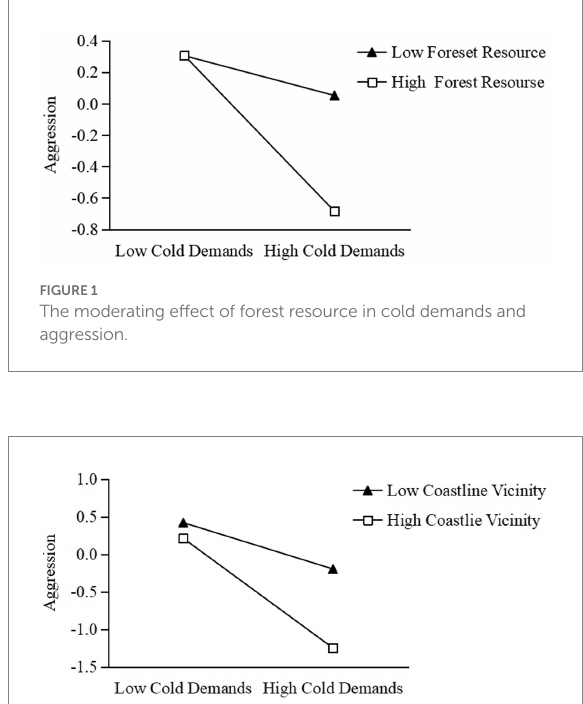
FIGURE 2 The moderating effect of coastline vicinity in cold demands and aggression.